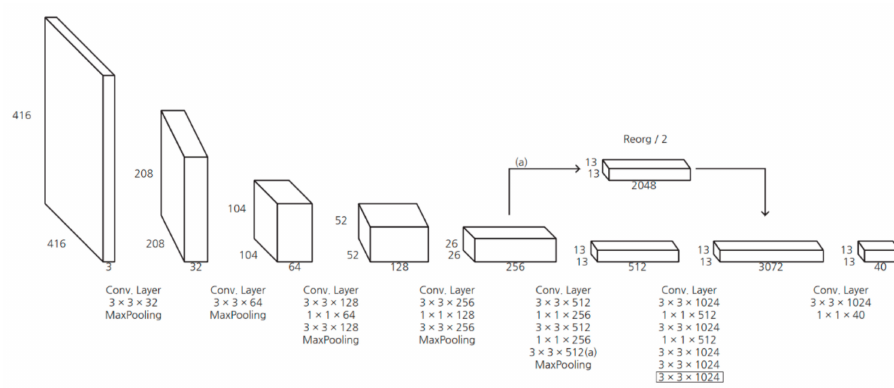
Figure 6. The architecture of